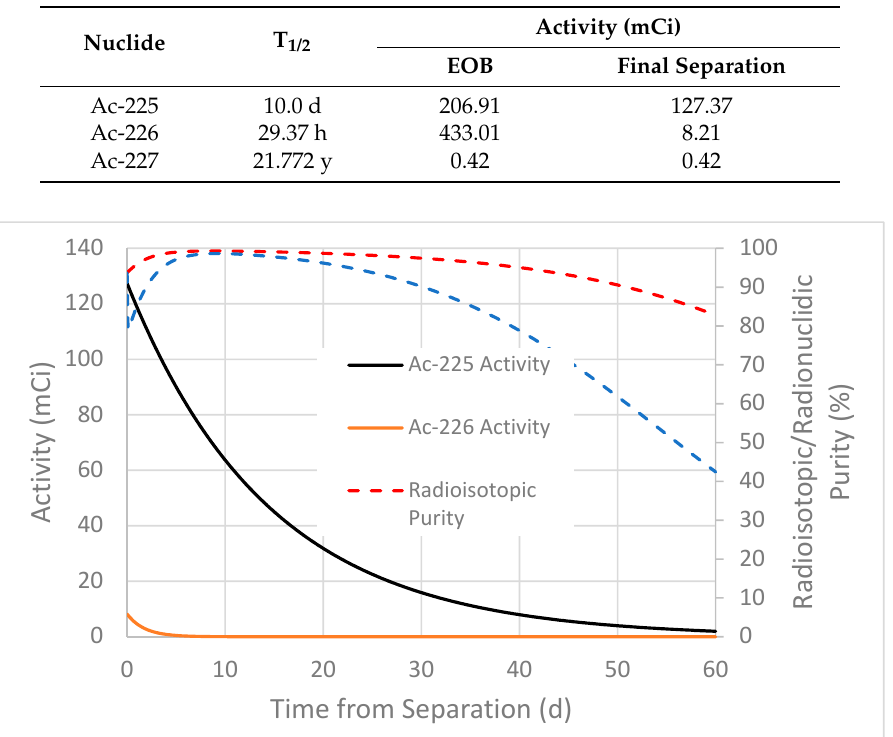
Figure 1. Experimentally calculated radionuclidic and radioisotopic purity of Actinum-225 (Ac-225) at BLIP. Radioisotopic purity includes only the Ac-225, Ac-226, and Ac-227 activity. Radionuclidic purity includes the activity of the previously mentioned actinium isotopes and the decay progeny generated by Ac-226 and Ac-227 over time. Irradiation parameters are specified in the caption for Table 2. Time 0 is the time corresponding to the end of processing (seven days after EOB).